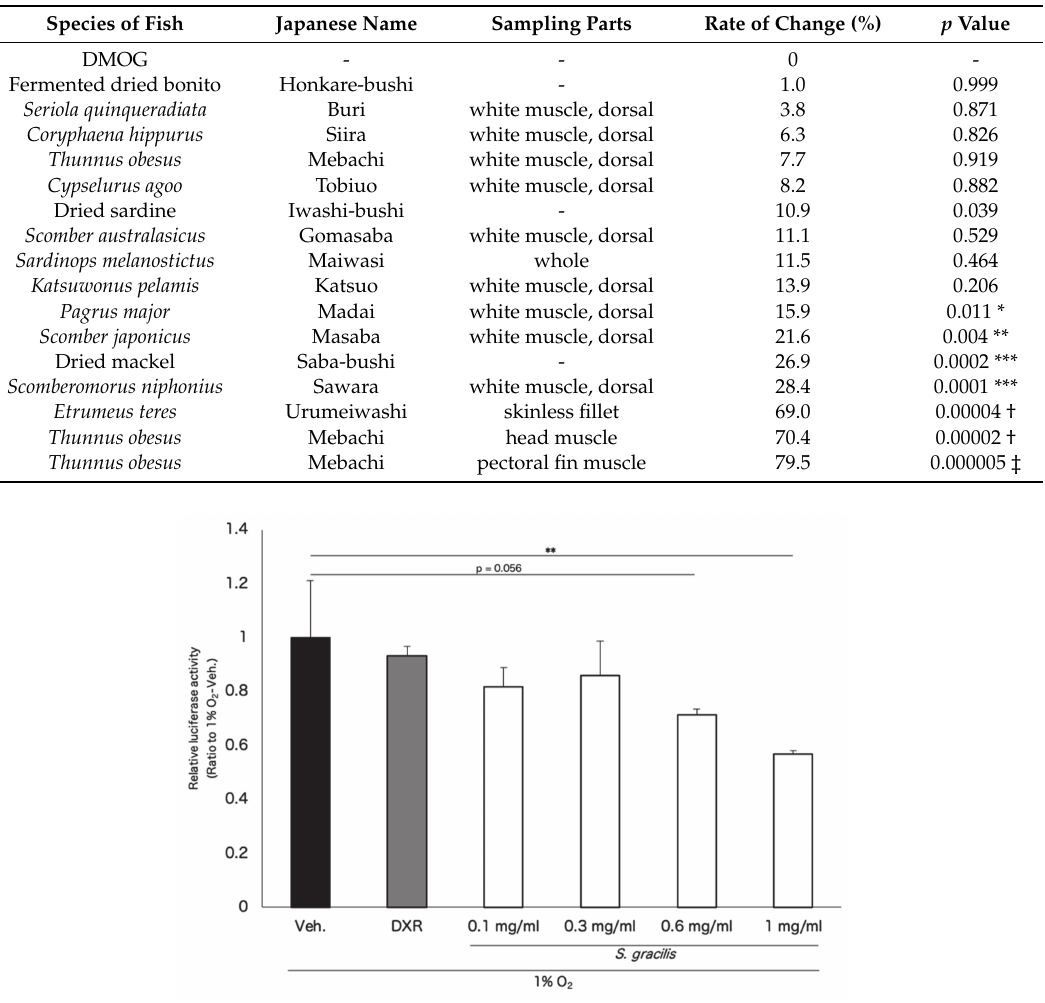
Figure A1. S. gracilis ingredients show inhibitory e ff ects on HIF activation in a dose-dependent manner in vitro . HIF-reporter luciferase assay was performed using the murine embryo fibroblast cell line (NIH-3T3). S. gracilis inhibited HIF activity induced by 1% oxygen in a dose-dependent manner. Note that S. gracilis showed significant HIF inhibitory e ff ect only at a concentration of 1 mg / mL. ** p < 0.01 compared with 1% O 2 -Veh. Error bars indicate mean plus SD. Veh., Vehicle; DXR,